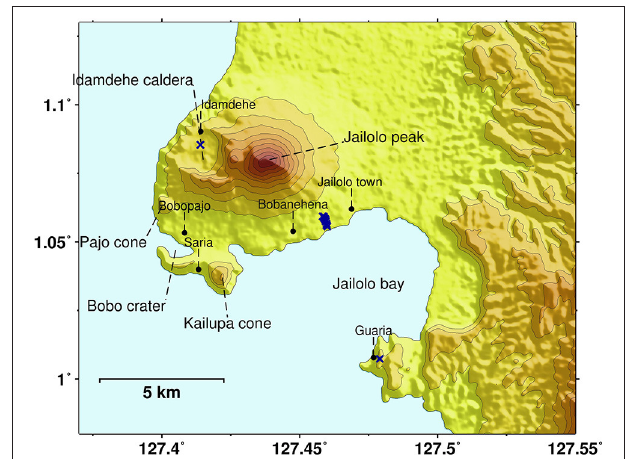
FIGURE 2 | Map of Jailolo volcano with the main structures indicated. The black circles indicate the larger villages and Jailolo town Topography is the SRTM 90m DEM (Jarvis et al., 2008) resampled at 30m and contour lines are 100m spaced. Blue crosses indicate the locations of the opening fractures in November